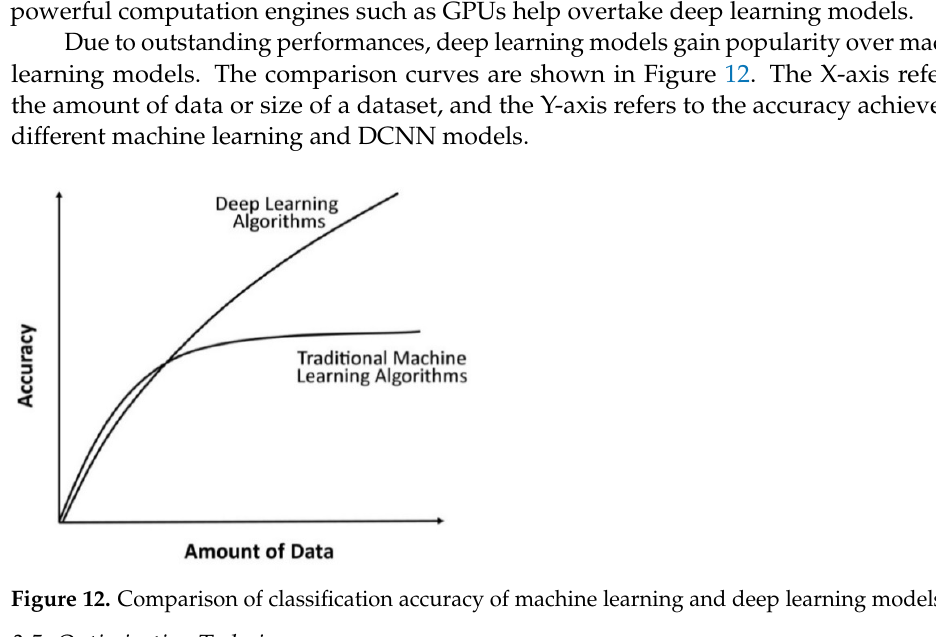
Table 4. Advantages and disadvantages of various optimization techniques.